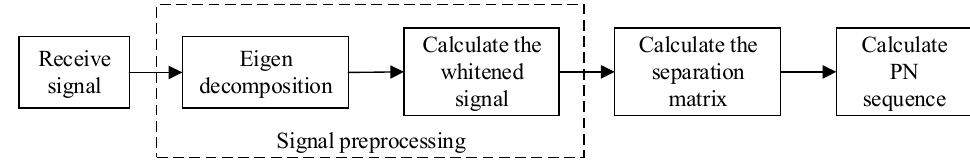
Figure 2. Frame diagram of spreading code estimation algorithm.